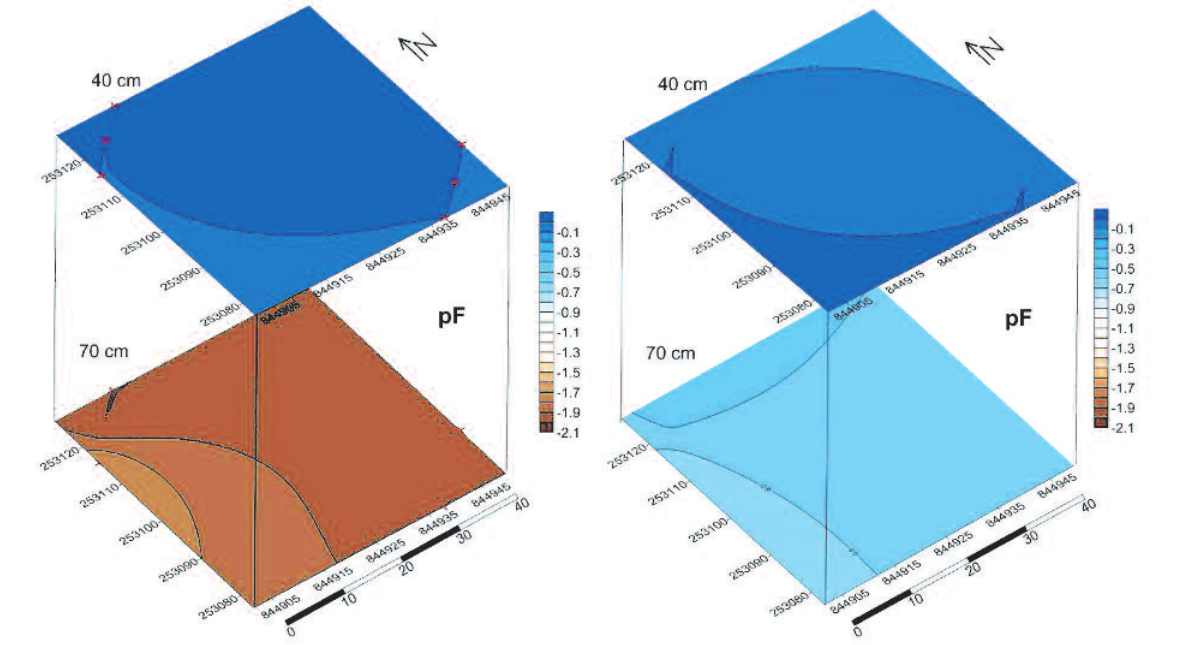
Figure 5: The pF